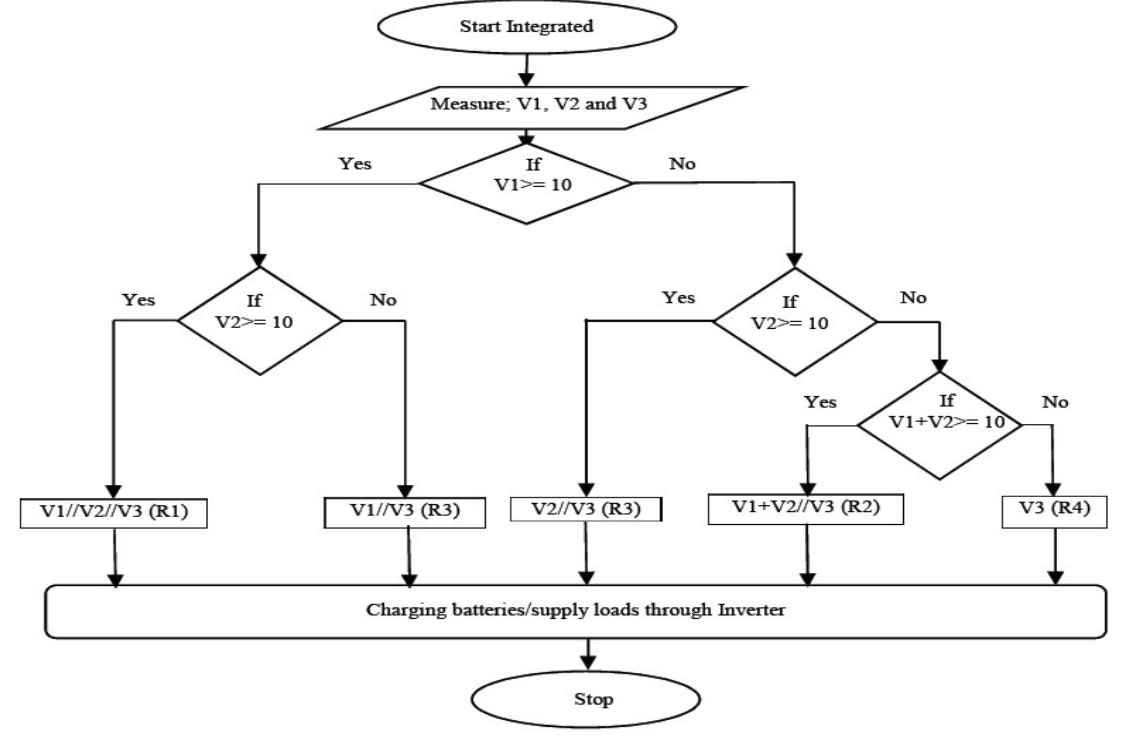
Figure 1. Integrated generation system flowchart.